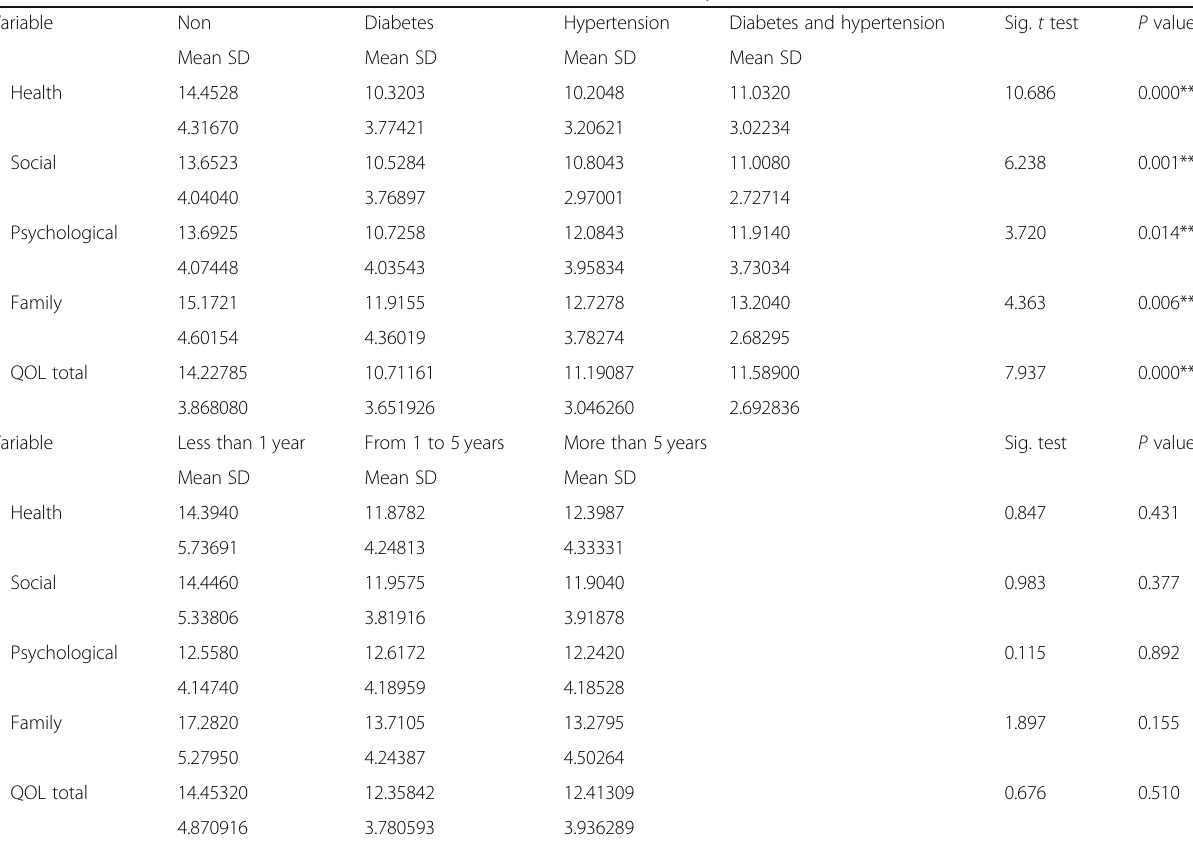
Table 5 Relation between QOL with clinical comorbidities and duration of dialysis and QOL Variable Non